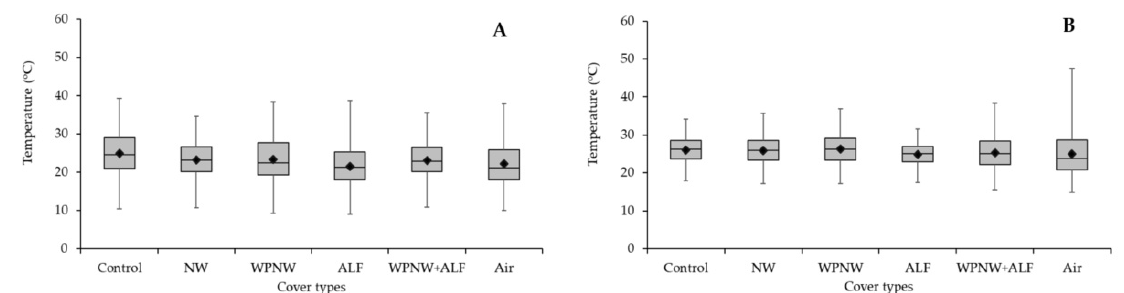
Figure 3. Box and whisker plots of temperatures inside cover materials and air temperature for the winter ( A ) and summer ( B ) trials. Boxes indicate the lower and upper quartile. The horizontal line in each box represents the median temperature. Average temperature for each treatment is indicated by ♦ . Vertical lines extending above and below each box represent minimum and maximum temperatures recorded. Table 3. Physical properties at mature green and chemical properties at ripening stage of Cavendish banana. Hand Weight Trial Treatment (g)